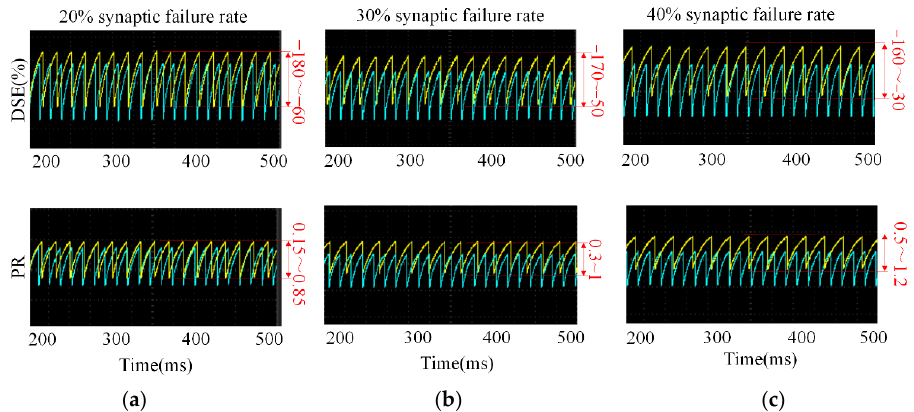
Figure 13. PR values and DSE signals at different failure rates, respectively: ( a ) 20% synaptic failure rate; ( b ) 30% synaptic failure rate; ( c ) 40% synaptic failure rate.